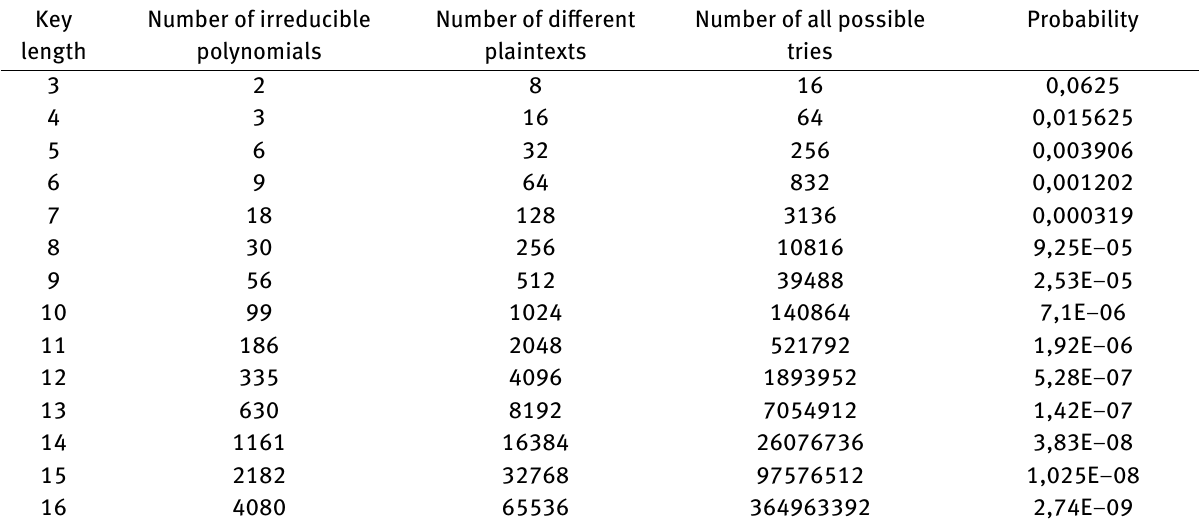
Table 1: Number of tries versus key length.